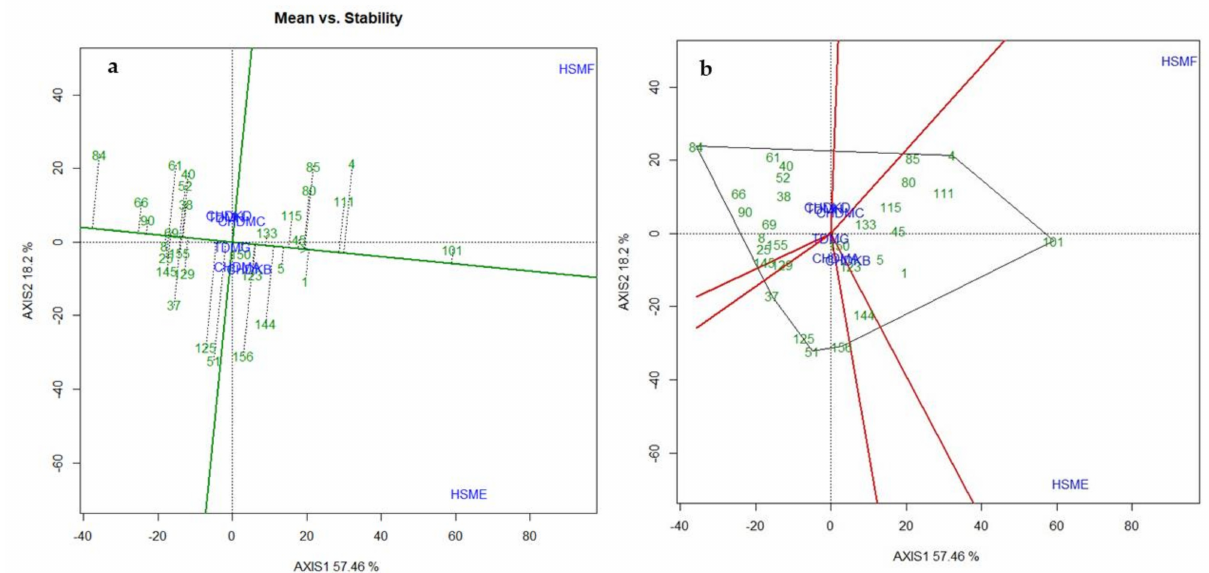
Figure 4. The “mean vs. stability” ( a ) and the“which-won-where” ( b ) hybrid plus hybrid × en- vironment interaction biplot constructed based on grain yield of the top 20 and worst 10 hybrids including the checks under CHDS, HS, and terminal drought environments during the 2018 and 2019 dry seasons in Ghana and